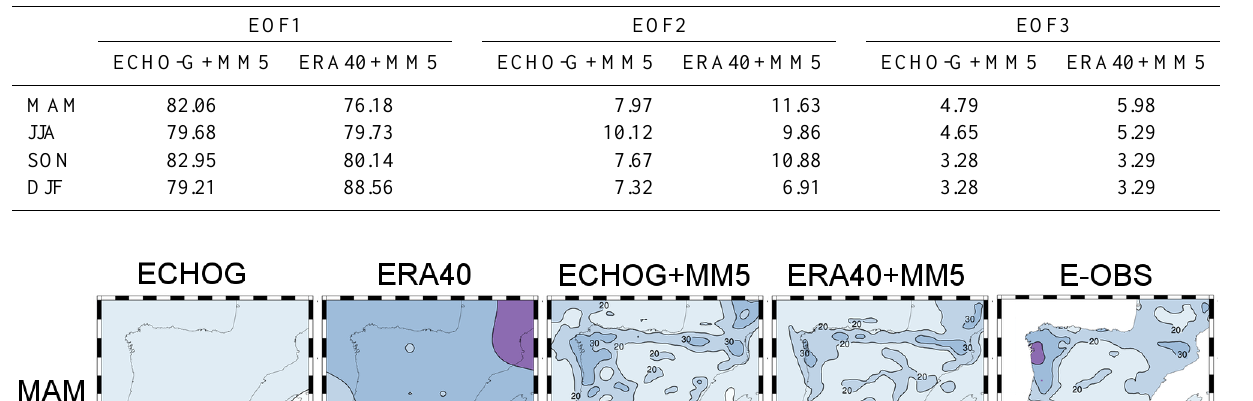
Table 1. Percentage of variance explained by each EOF of the seasonal mean series of SAT.